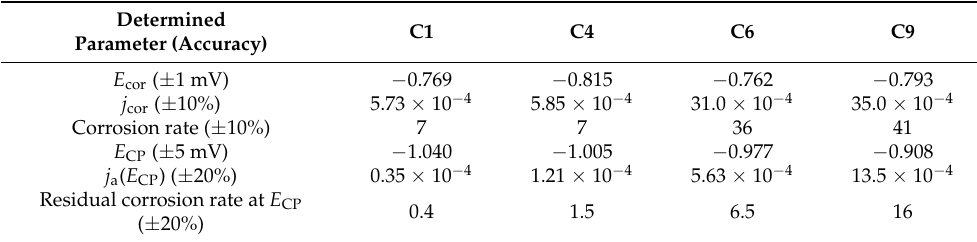
Table 3. Voltammetry measurements and data obtained via the extrapolation of the anodic Tafel line down to E CP . E cor is given in V vs. Ag/AgCl-seawater, j cor and j a ( E CP ) in mA cm − 2 , and the corrosion rate and residual corrosion rate in µ m yr − 1